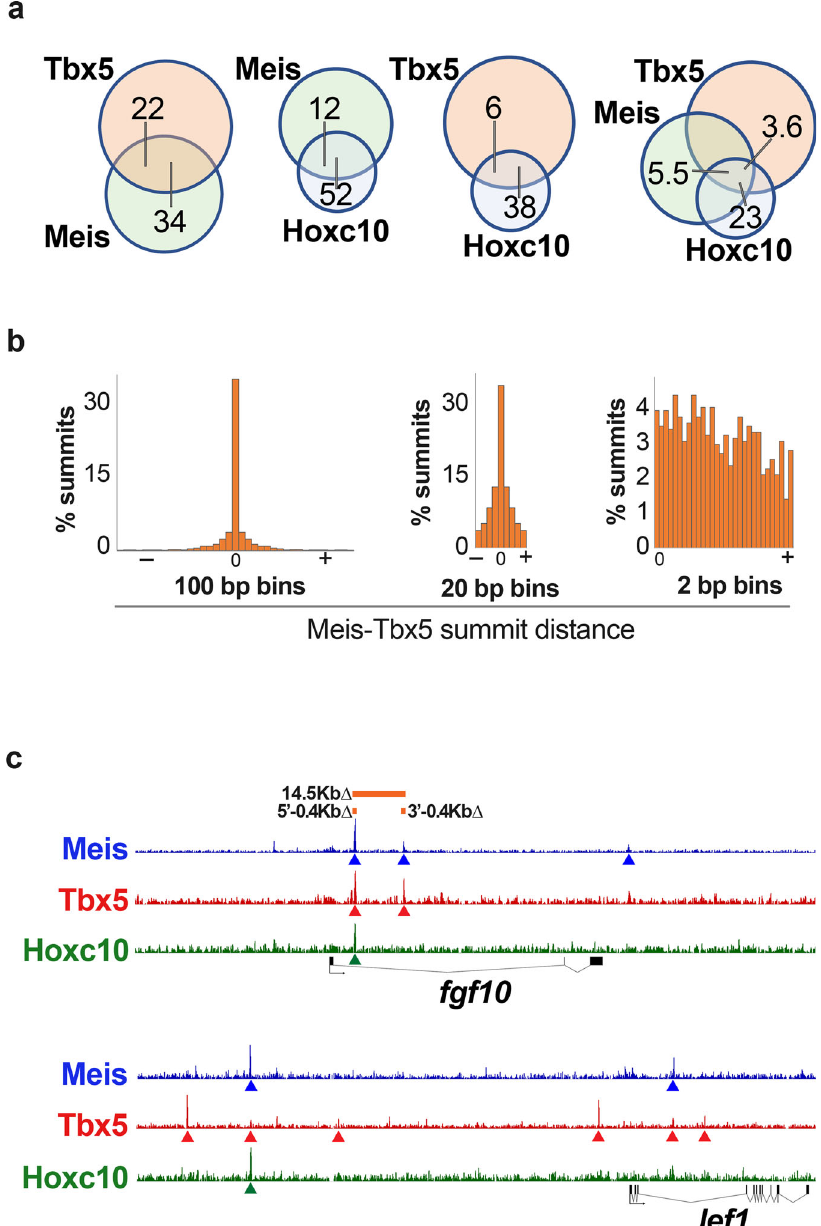
Fig. 5 Meis, Tbx, and Hox transcription factors co-bind regulatory sequences of genes involved in limb initiation. a Overlap (%) between ChIP-seq- binding sites for Tbx5, Hoxc10, and Meis. The size of the circles representing each class is proportional to the number of binding sites for each factor (Meis: 6811; Tbx5: 10273; Hoxc10: 1611). b Meis – Tbx5 summit distance distribution at different resolutions. c Binding sites shared by Meis, Tbx5, and Hoxc10 in the Fgf10 and Lef1 loci. See the “ Data availability ” section for source